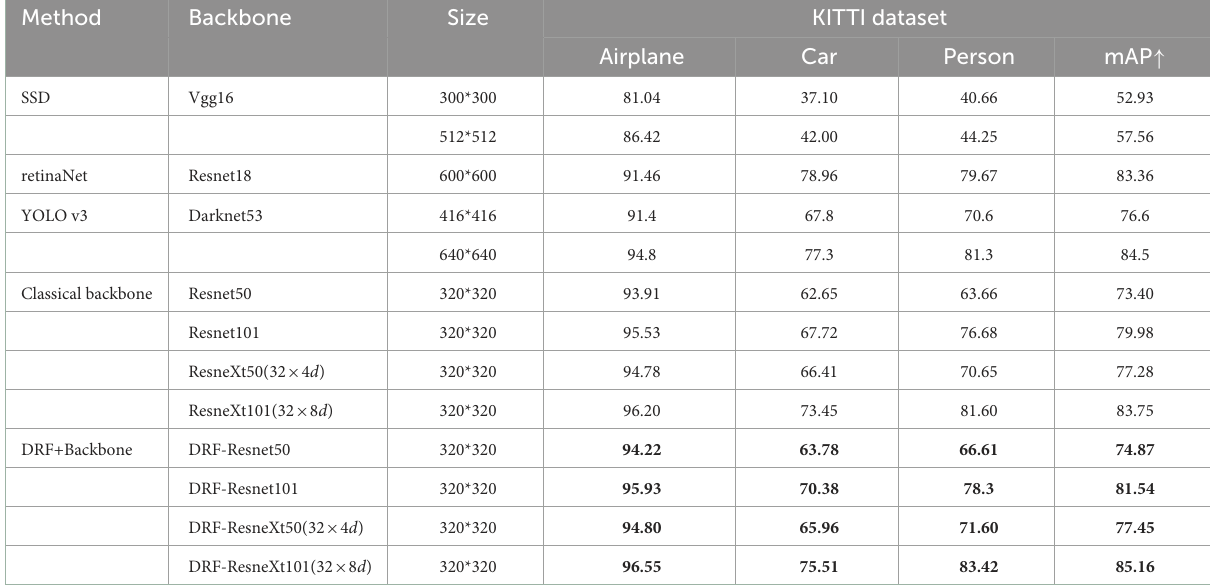
TABLE 7 Performance comparisons with various SOTA detection frameworks on the KITTI